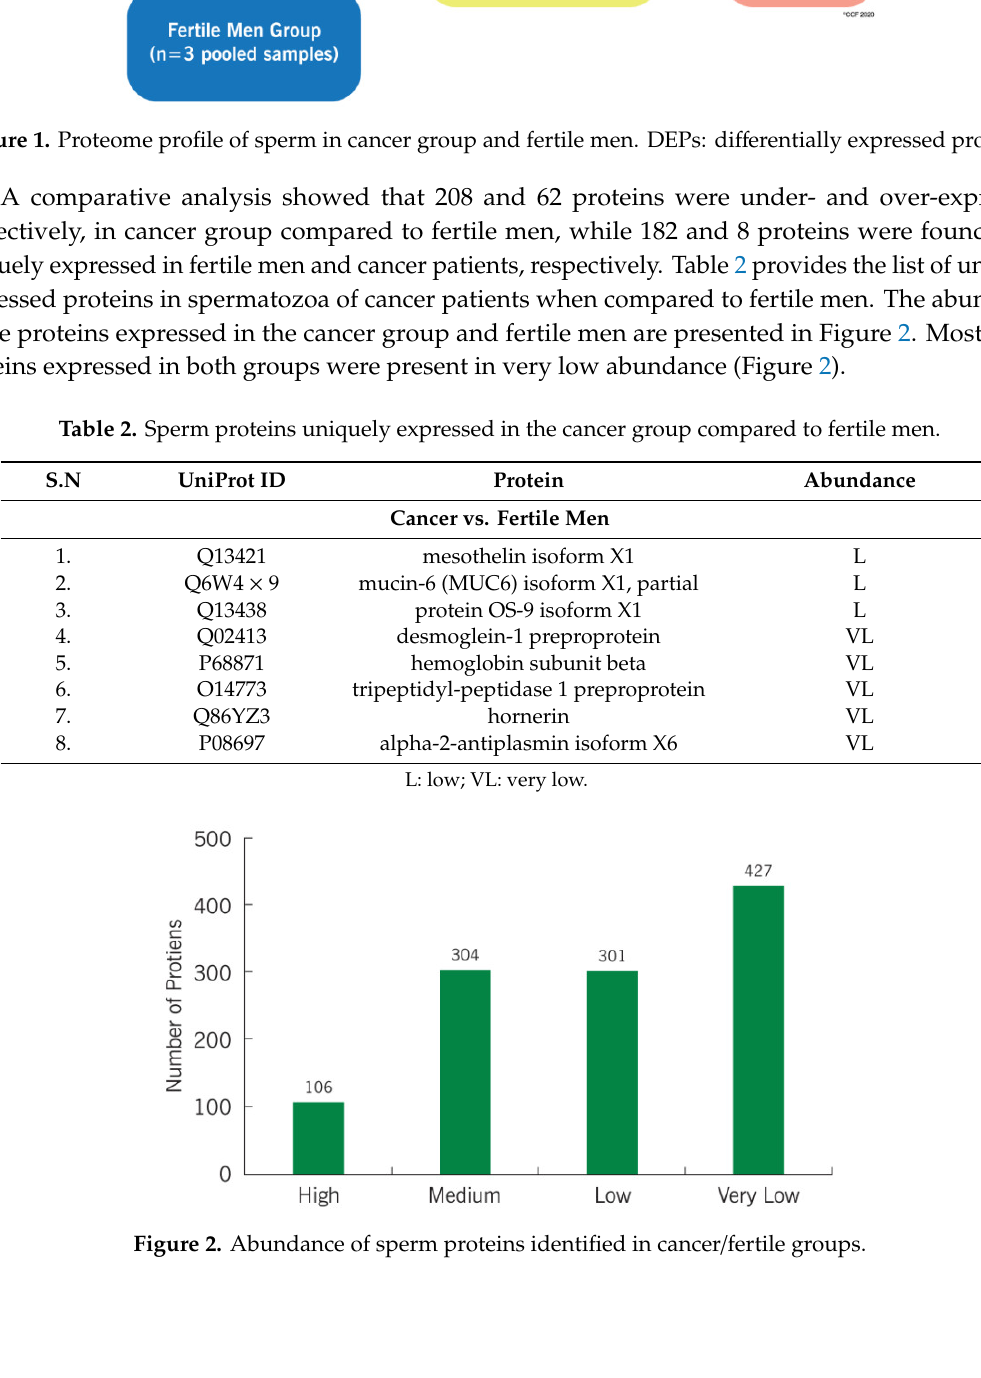
Figure 2. Abundance of sperm proteins identified in cancer/fertile groups.